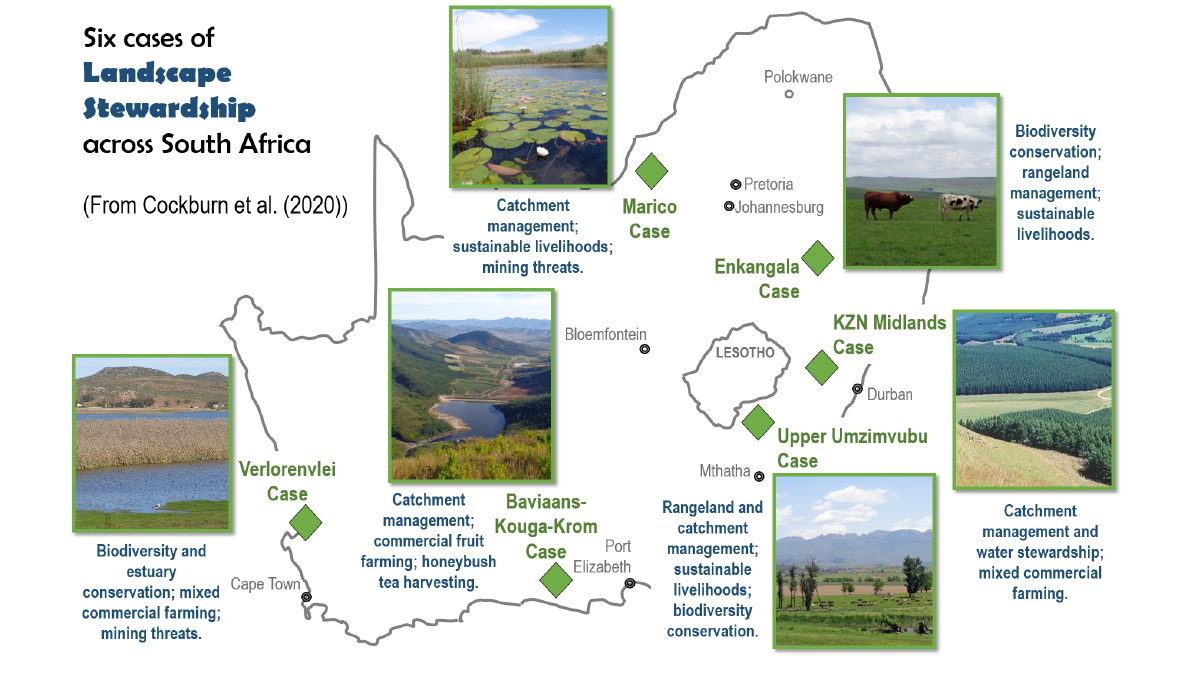
Fig. 2 . Cases of collaborative landscape stewardship studied to understand collaboration and the influence of context through the application of the realist CMO framework (see Box 1; Figure from Cockburn 2018 and Cockburn et al.